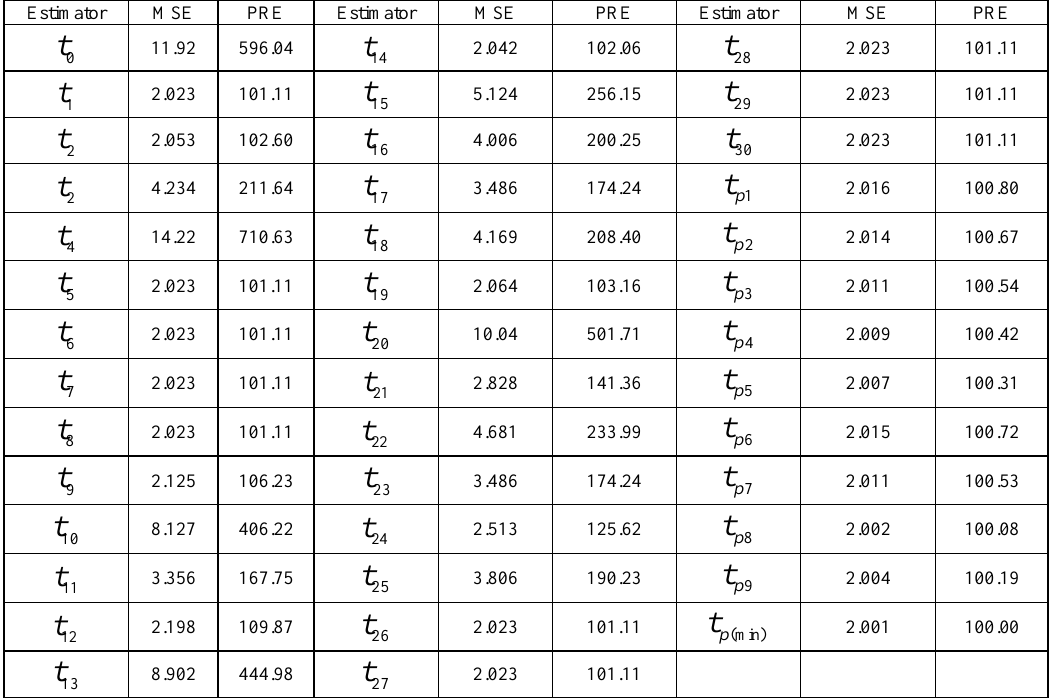
Table 5. MSE of various estimators and PRE of proposed class over competing estimators Estimator